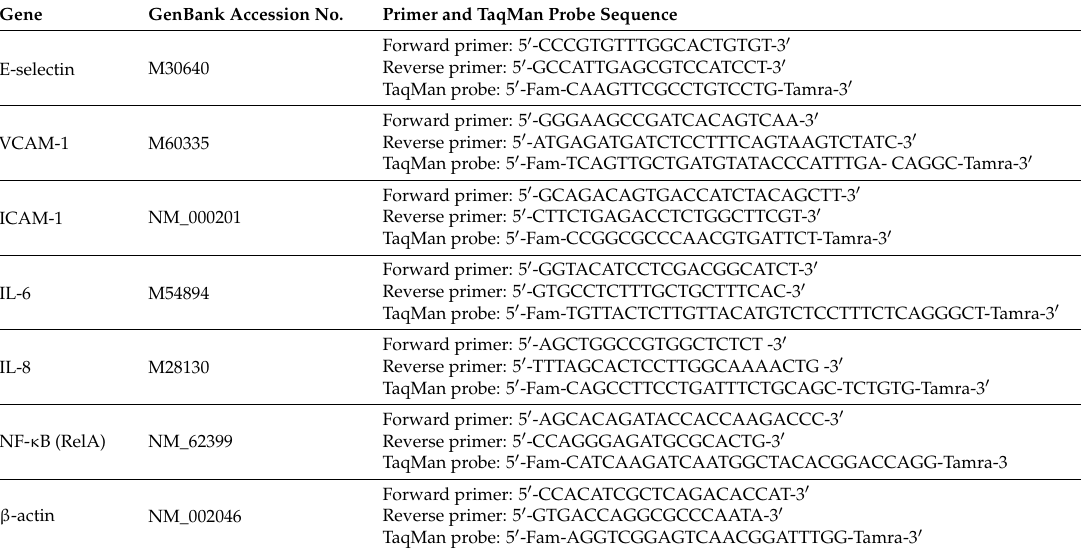
Table 2. Sequence of primers and probes used for real-time